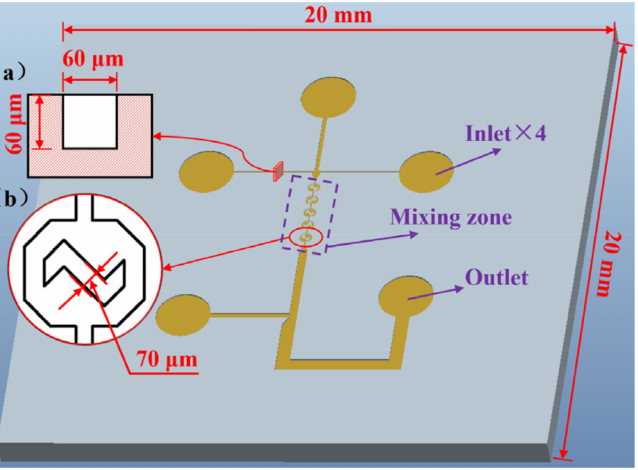
Figure 1. Microfluidic chip designed for heavy metal detection: ( a ) cross section of the micro-channel, ( b ) enlarged view of the micro-mixing structure.